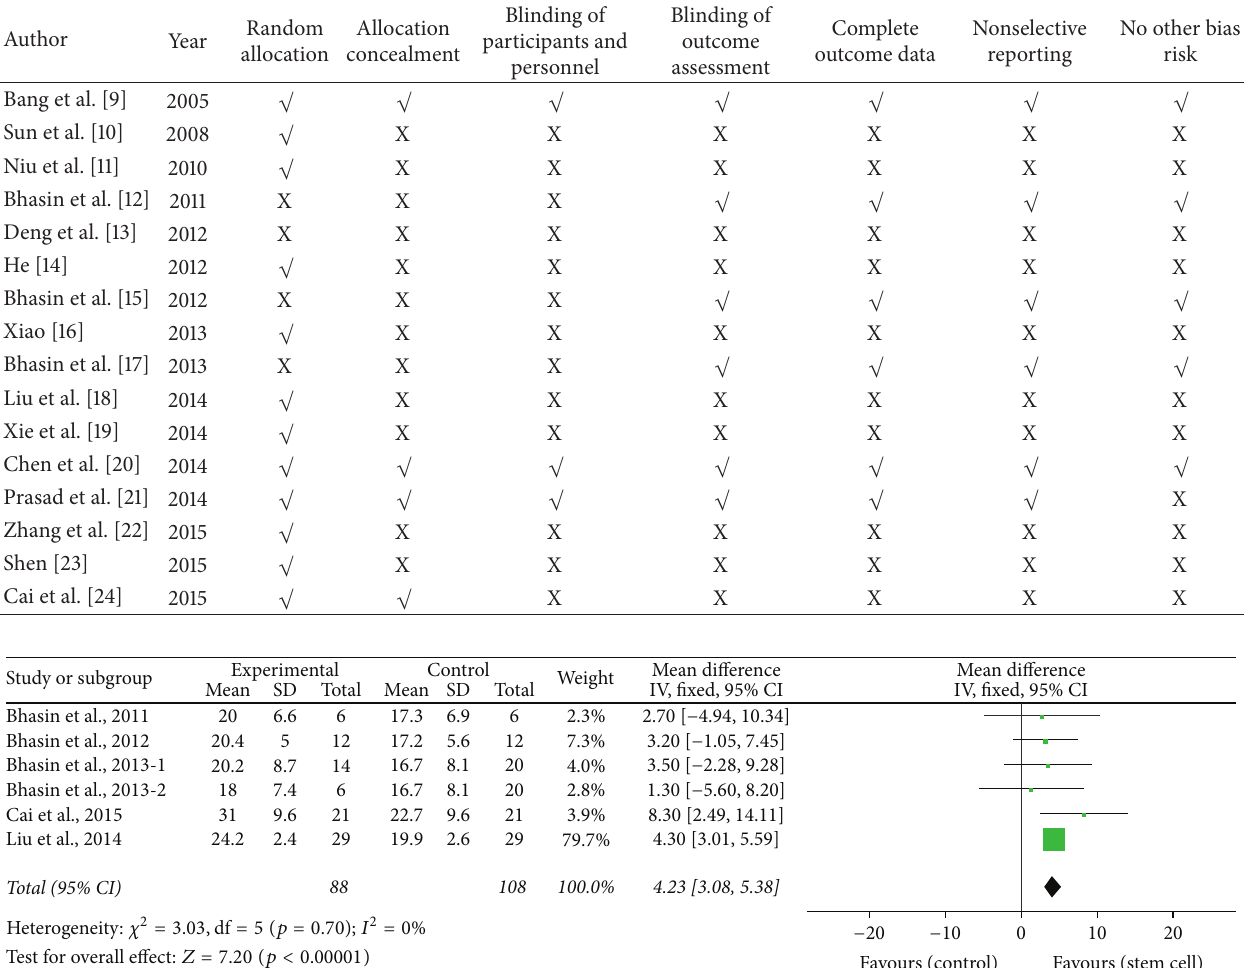
Table 2: Study quality or risk of bias report.